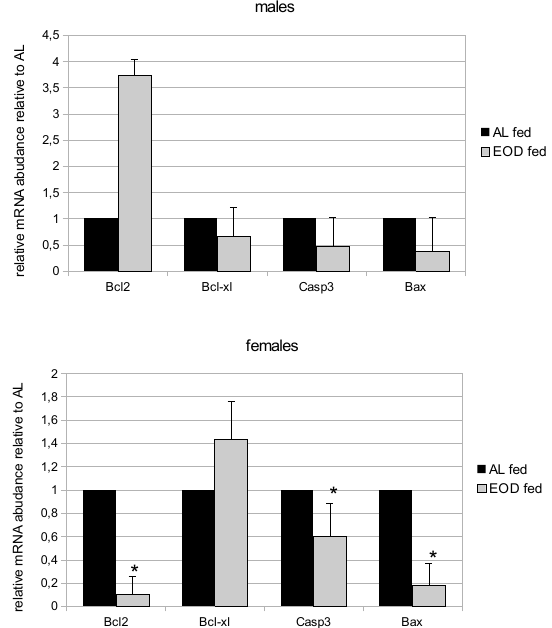
Figure 3. Expression of mRNA for chosen proapoptotic and antiapoptotic proteins in male and female mice on EOD diet and AL fed. Data expressed as relative mRNA abundance—fold change relative to control (AL). Significantly different from AL group * p < 0.01.